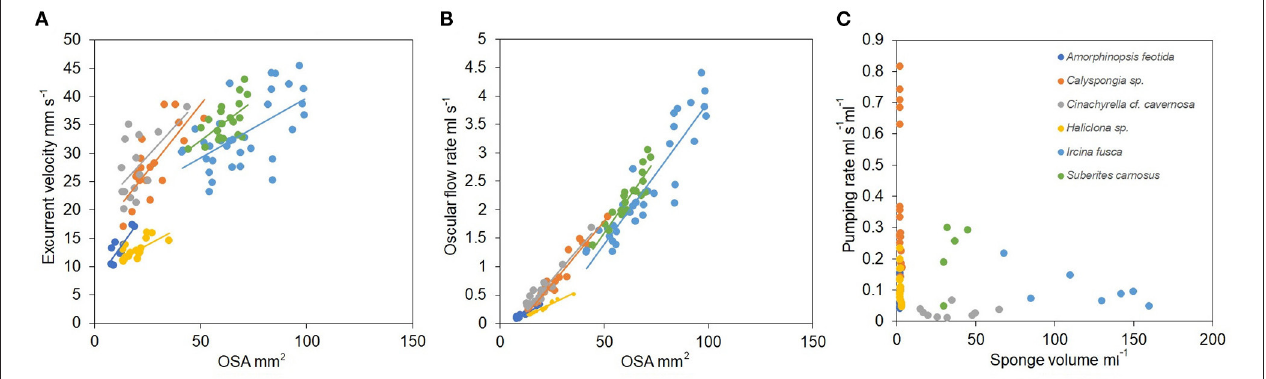
FIGURE 4 | (A) Relationship between the excurrent velocity (mm s − 1 ) and the osculum cross sectional area (mm 2 ). (B) Relationship between the oscular flow rate (ml s − 1 ) and the oscular cross sectional area (mm 2 ). (C) Pumping rate (ml s − 1 ml − 1 ) vs. sponge volume (ml).